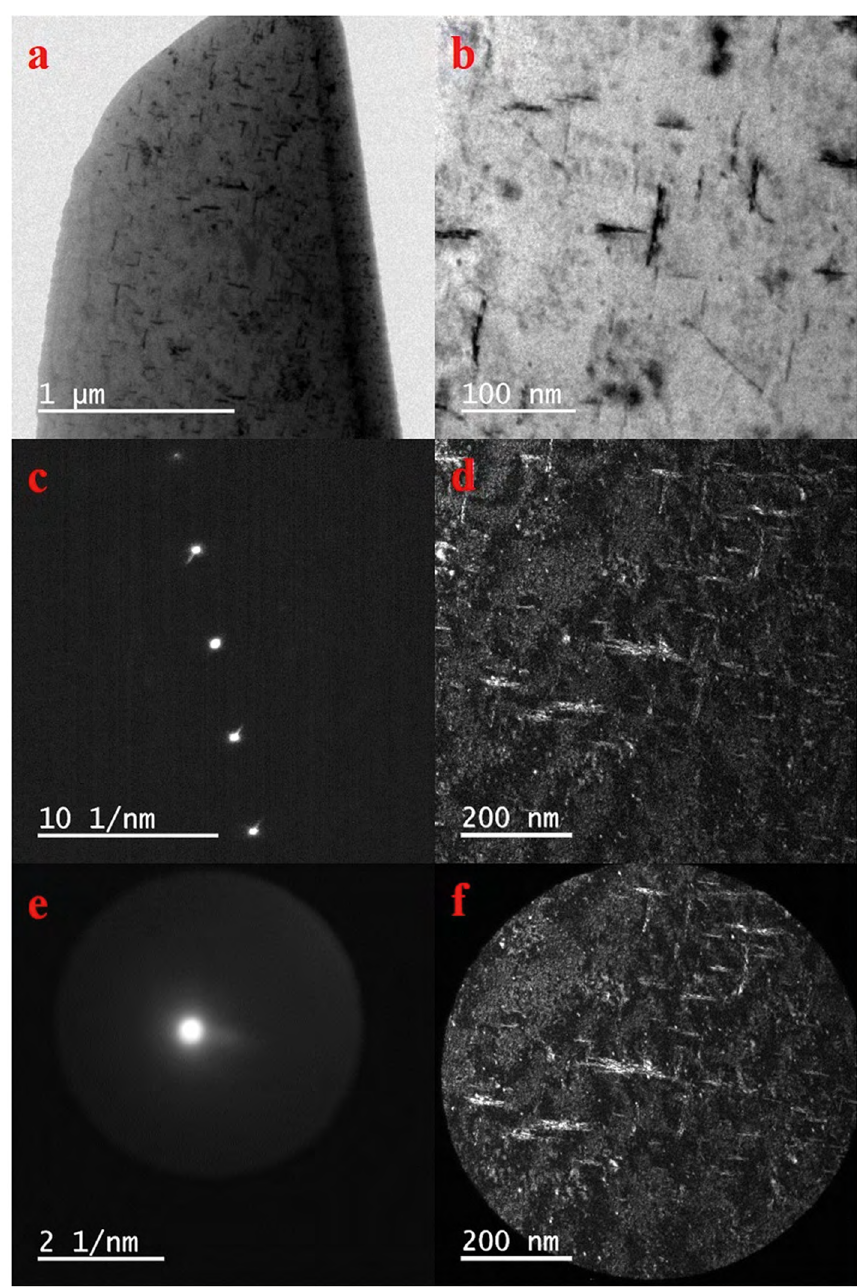
Figure 12. (a) TEM micrograph of D2 sample; (b) Detail of TEM micrograph showing the chromium nitrides in detail, highlighting the needles morphology; (c) Diffraction profile of ferritic matrix coincident with Cr (d) elastic scattering image correspondent to the Fig. 12-c; (e) Detail of diffraction profile of ferritic matrix coincident with Cr N; (f) elastic scattering image correspondent to the Fig. 2